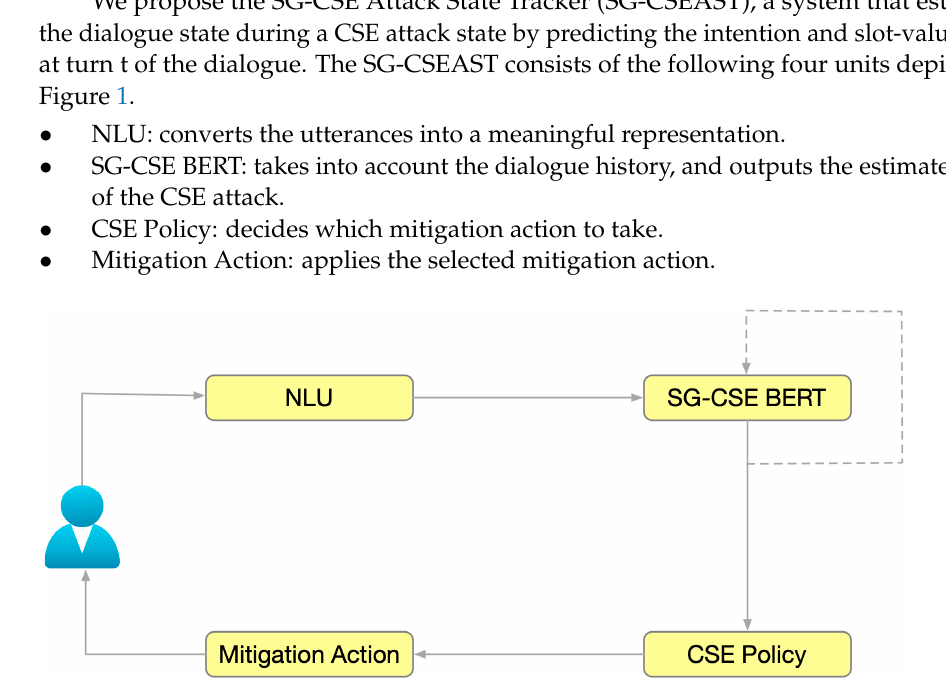
Figure 1. The SG-CSE a tt ack State Tracker main